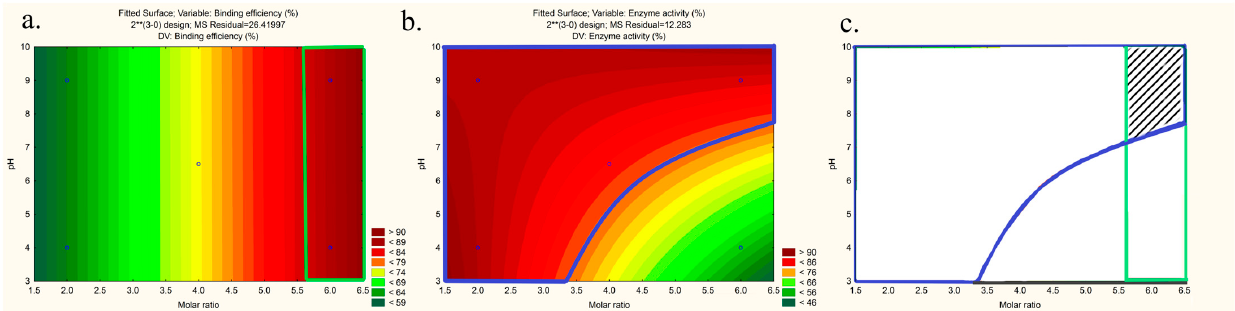
Figure 3. Contour plots of the ( a ) binding efficiency and ( b ) enzyme activity at 31 ◦ C with acceptance criteria, and ( c ) illustration of the design space (marked area indicates the process design space).